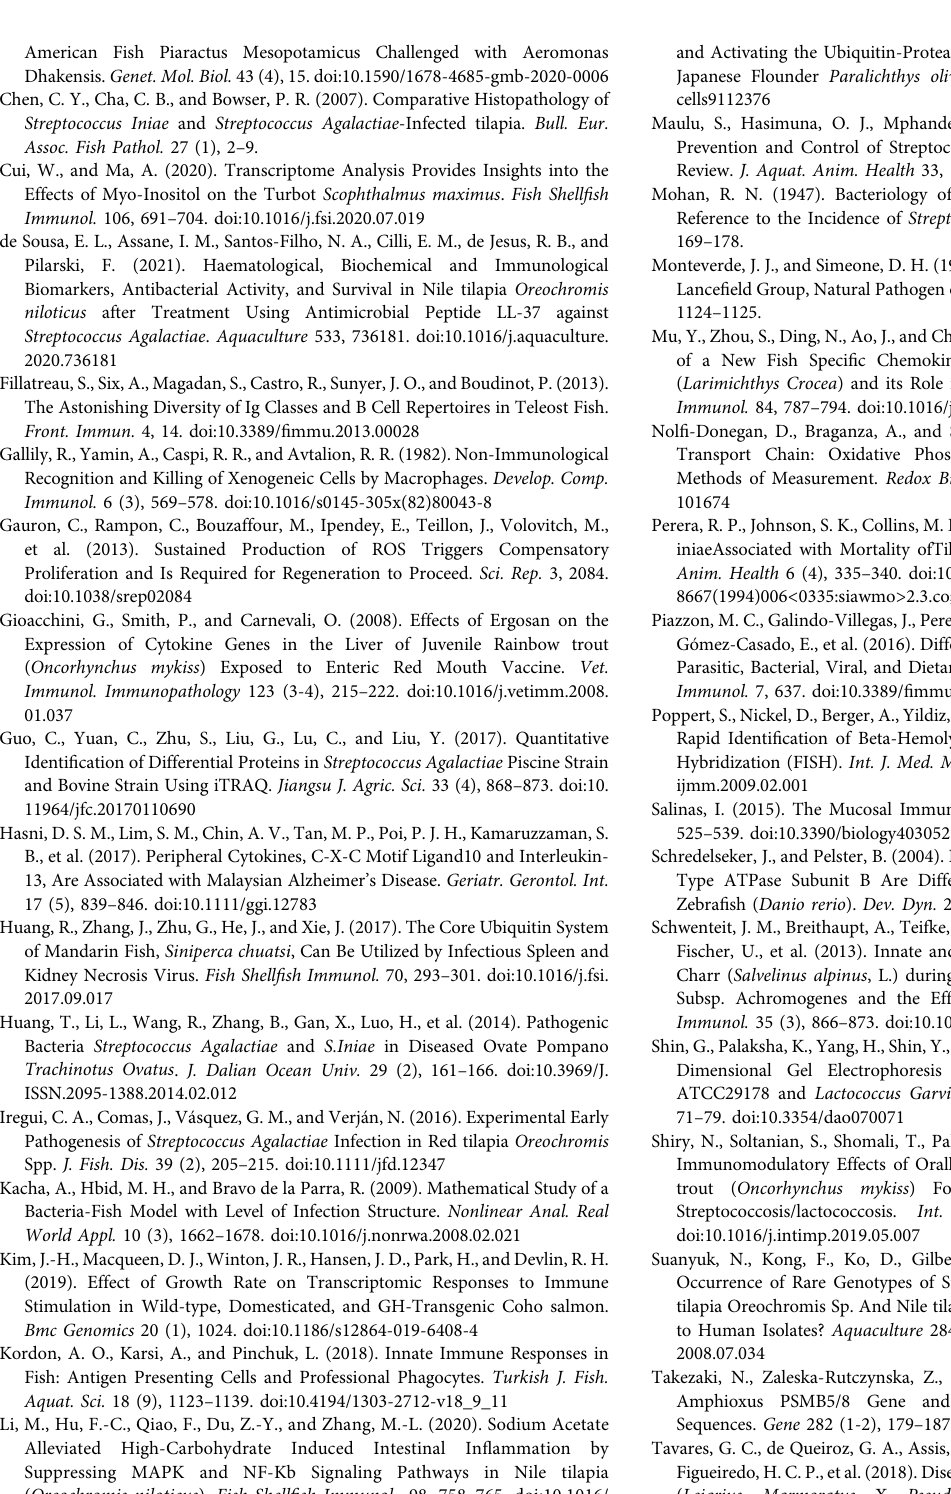
Figueiredo,H.C.P.,etal.(2018).DiseaseOutbreaksinFarmed AmazonCat fi sh ( Leiarius Marmoratus X Pseudoplatystoma Corruscans ) Caused